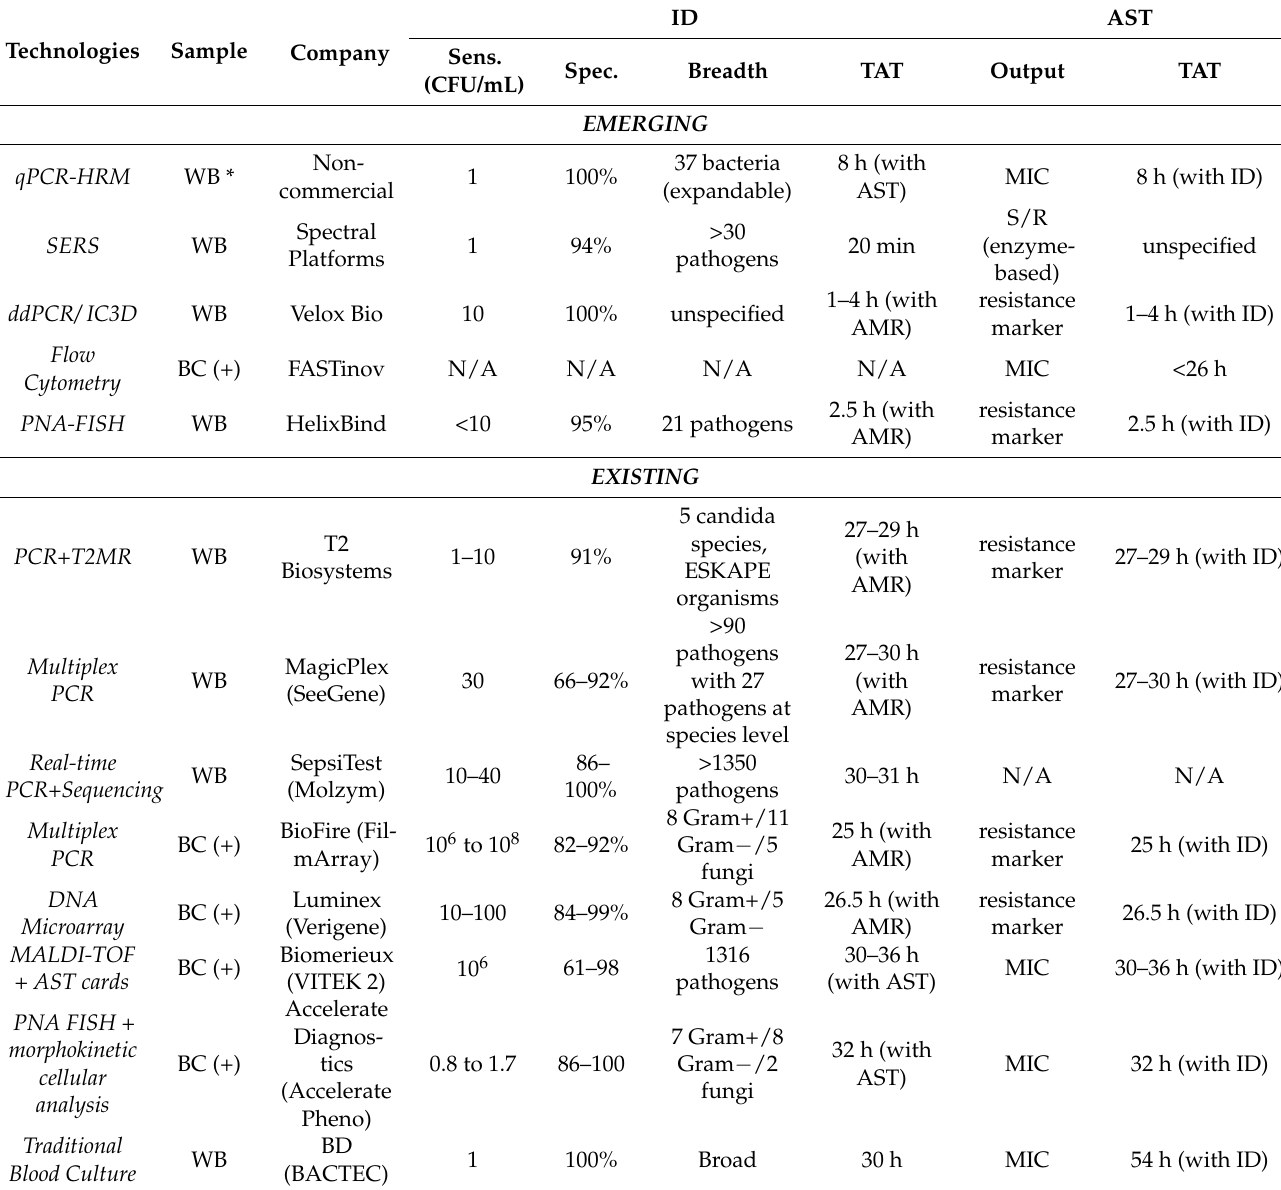
Table 3. Comparison of Existing and Emerging BSI Diagnosis